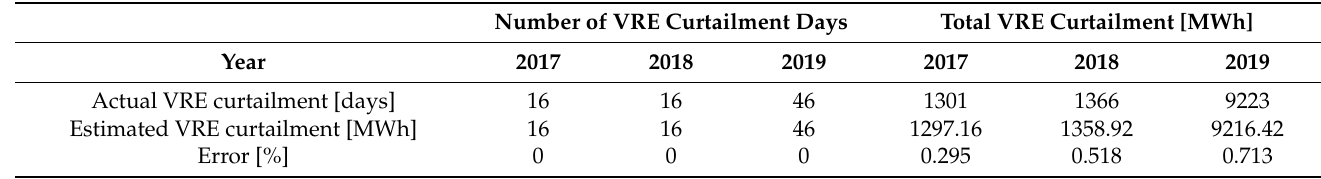
Table 5. Error between actual and estimated VRE curtailment for 2017, 2018, and 2019 in Jeju. Number of VRE Curtailment Days Total VRE Curtailment